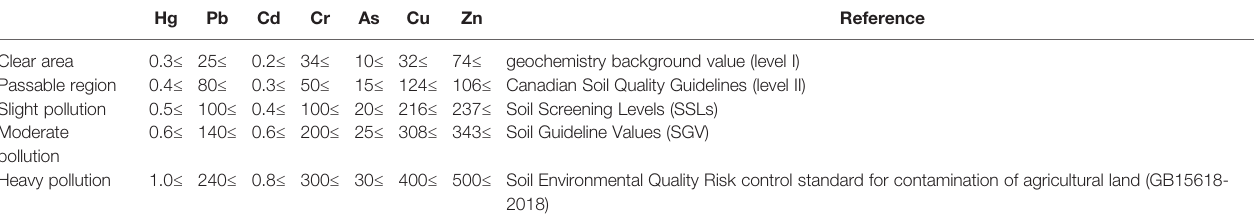
TABLE 5 | Grade evaluation of heavy metal pollution in soils (mg/kg). Hg